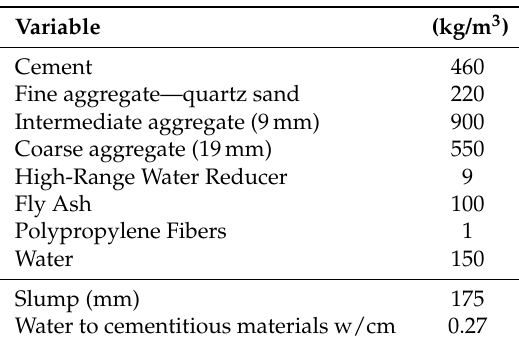
Table 2. Properties of concrete